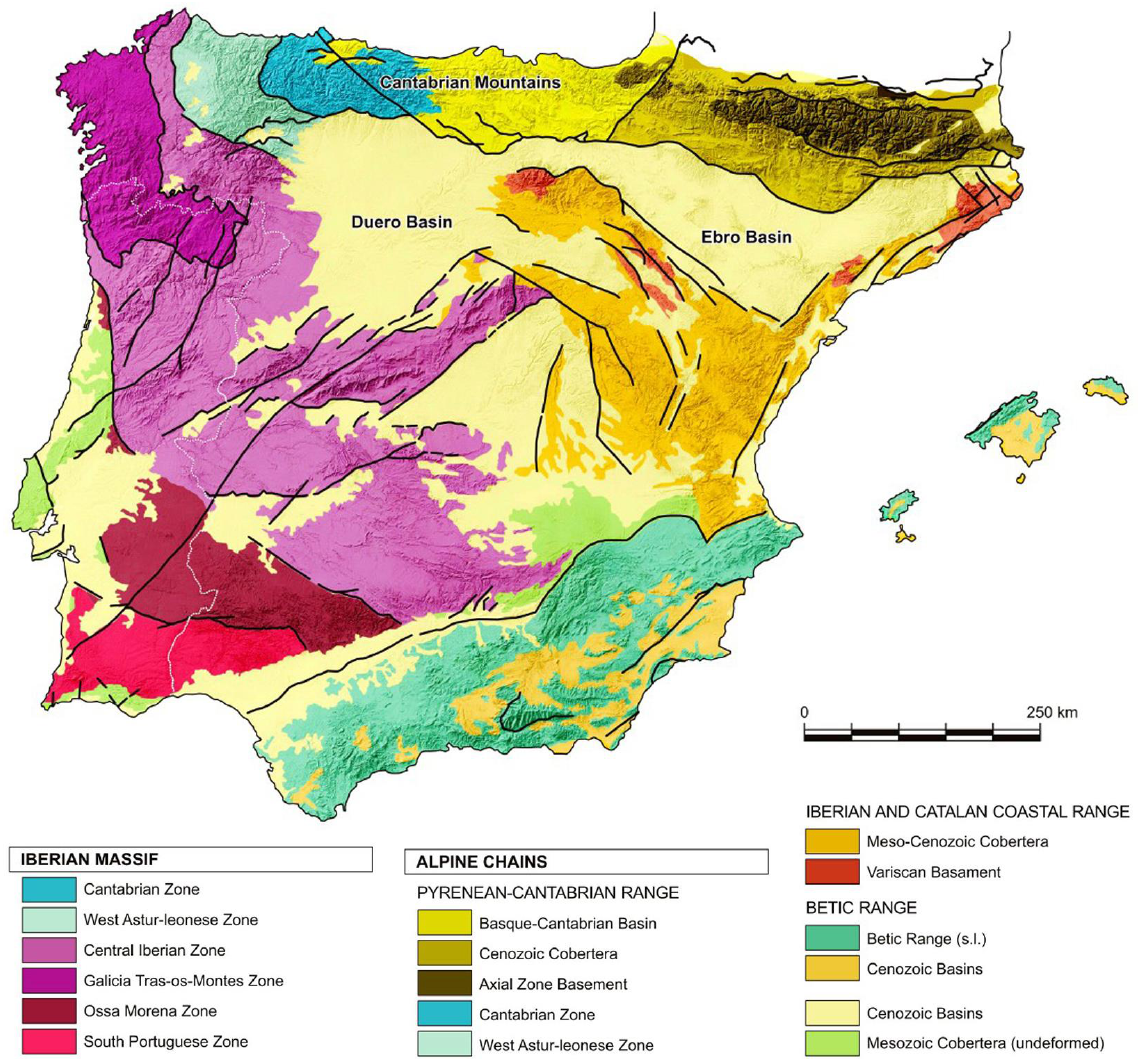
Figure 2 : Geological map of Iberian Peninsula. Modified after Vera et al. (2004) and PePeEfe